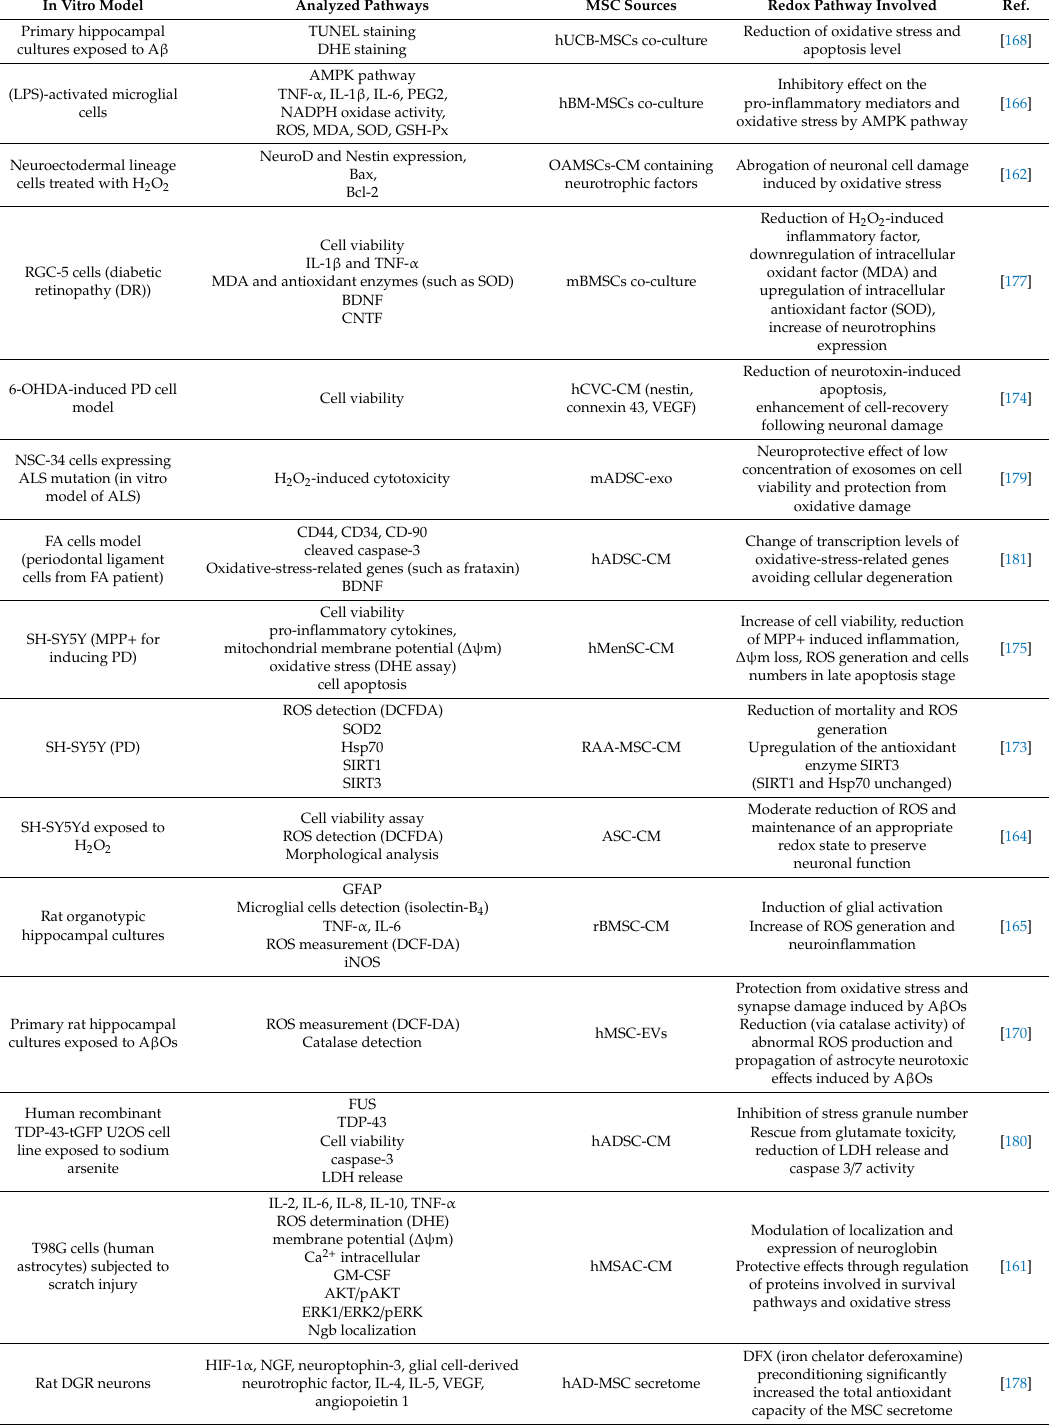
Table 2. MSC studies on in vitro models of neurodegenerative